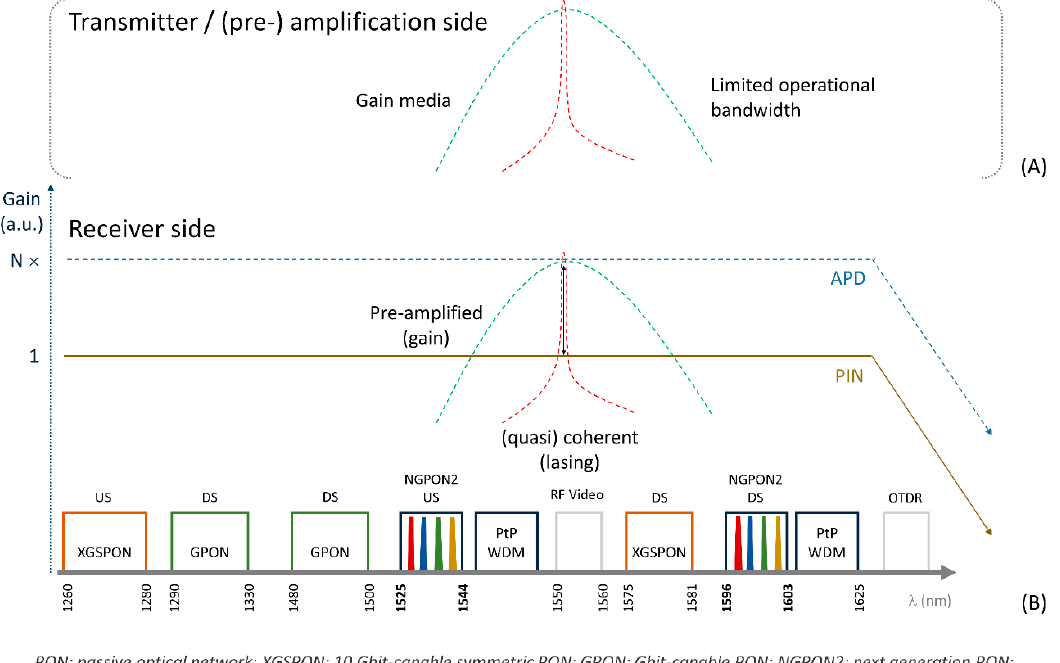
Figure 7. Diagram describing transmitter and receiver technologies with potential use in access networks. Typical gain and lasing media profiles are presented, with 20 nm to 60 nm bandwidths for common current materials, PINs with di ff erent doping materials, and APDs. ( A ): transmitter / (pre-) amplification side; ( B ): receiver side.